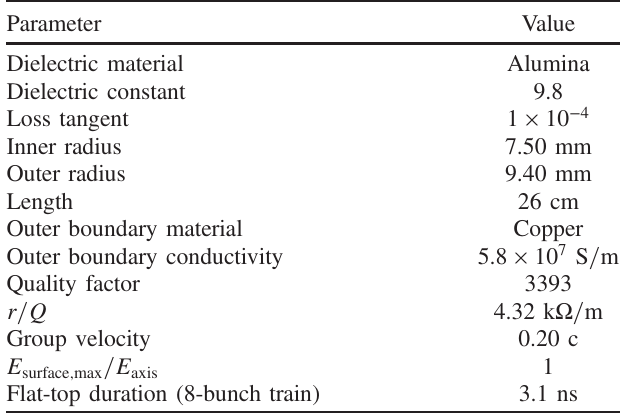
TABLE I. Parameters of the uniform